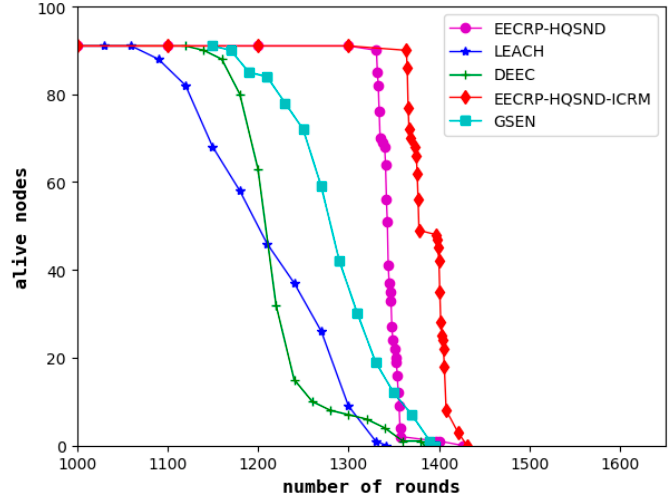
Figure 15. The number of live nodes varies with the iteration round. DEEC— Distribute Energy-E ffi cient Clustering; EECRP-HQSND—energy-e ffi cient clustering routing protocol based on a high-QoS node deployment; EECRP-HQSND-ICRM—energy-e ffi cient clustering routing protocol based on a high-QoS node deployment with an inter-cluster routing mechanism; GSEN— and Group-Based Sensor Network; LEACH—Low-Energy Adaptive Cluster Hierarchical.